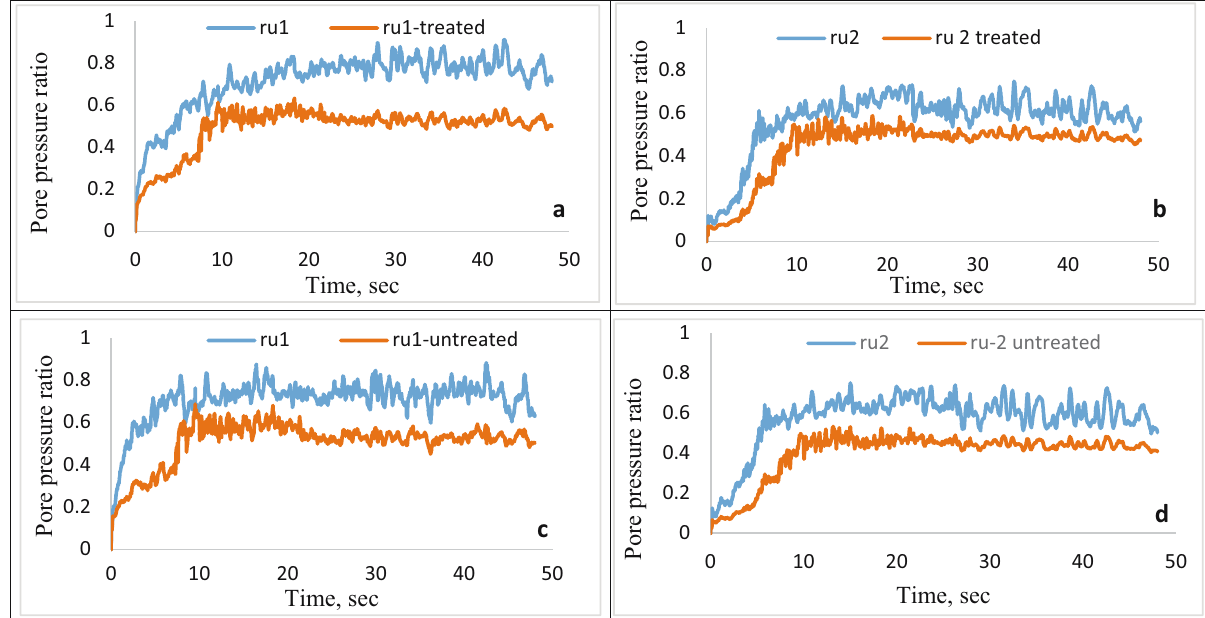
Figure 12: Pore pressure ratio within treated and untreated soil with nano - clay: ( a and b ) ru1 - and ru2 - treated at 50% axial load and 50% axial load and 100% lateral load; ( c and d ) ru1 - and ru2 - untreated at 100% axial load and 100% axial load and 100% lateral